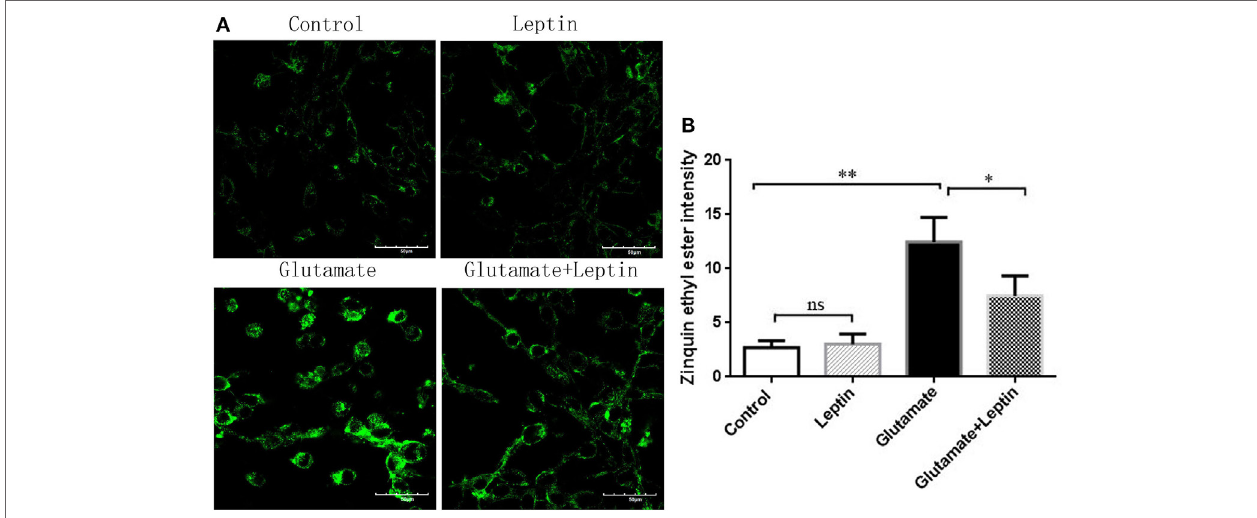
FigUre 6 | The effect of leptin on zinc ion level in glutamate-treated HT22 cells. (a) The fluorescence intensity of Zinquin ethyl ester in HT22 cells; (B) the quantitative analysis of the average fluorescence intensity of Zinquin ethyl ester in HT22 cells. * P < 0.05, ** P < 0.01, ns, not